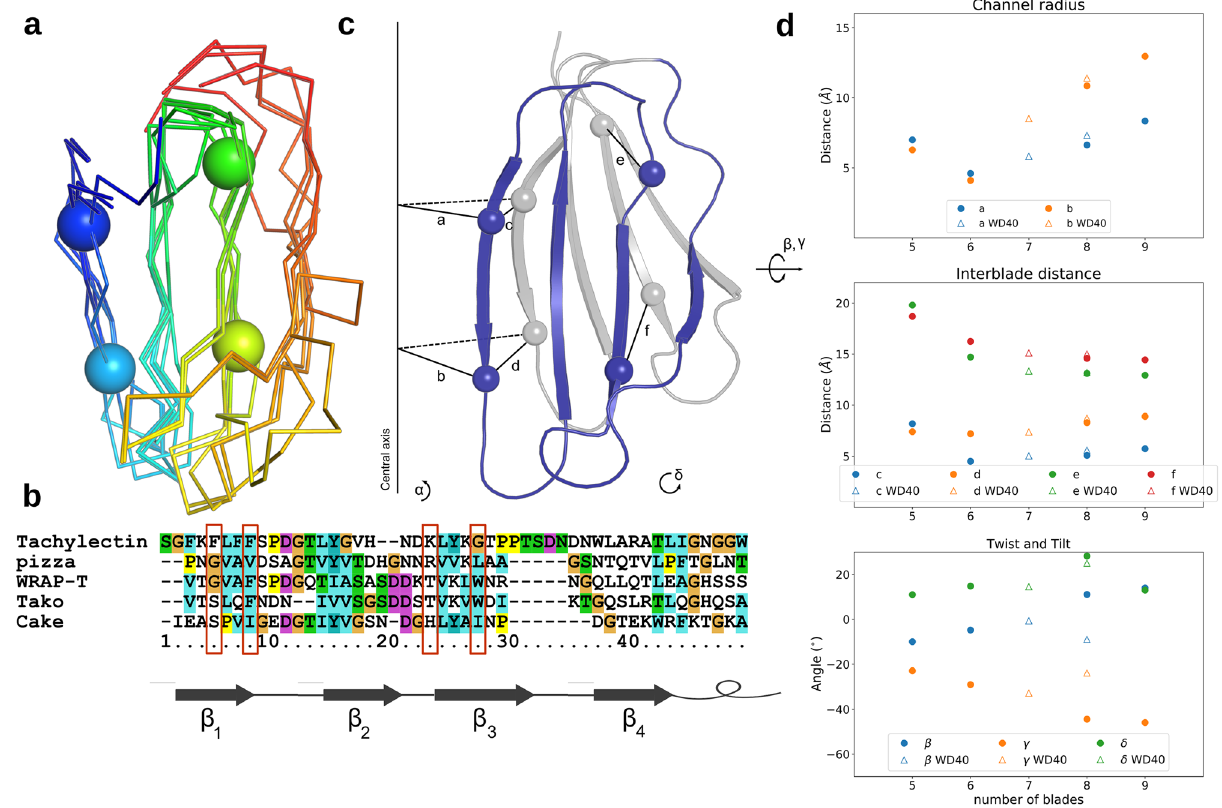
Figure 5. Geometric analysis of different symmetric designer proteins: the five-fold Tachylectin-2 (PDB:5c2m), the six-fold Pizza (PDB:3ww9), seven-fold WRAP-T (PDB:7big), eight-fold Tako (PDB:6g6n) and Cake (PDB:6tjg) and the nine-fold Cake (PDB:6tjh). An alignment of a single blade from each protein. The spheres indicate the location of the chosen reference point ( a ). A structure based sequence alignment of a single blade from each protein, the red boxes show the location of the sphere reference point in each sequence ( b ). A cartoon of two subsequent blades with spheres indicating the reference points. The chosen parameters are shown: The distances from the inner position to the central axis ( a , b ); the distance between reference points in subsequent repeats, for inner points ( c , d ) and outer points ( e , f ); the rotation angle ( α ); the twist angles of the blade as the dihedral angle between the β 1 -strand and the central axis ( β ) and the internal dihedral angle between the two strands ( γ ); and the tilt angle between the central axis and the β 1 -strand ( δ ) ( c ). Graphs showing the average value for each parameter in function of repeat number. WRAP-T and Tako are both WD40 repeats and are represented by a hollow triangle, the other proteins belong to different families and are shown as a solid circle ( d ). Panels ( a , c ) were created with PyMOL 23 .